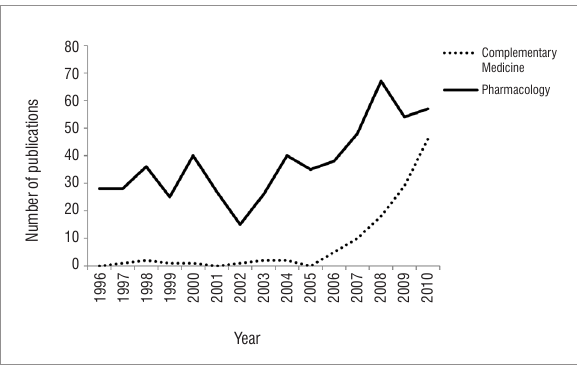
Figure 9: Number of publications from South Africa in Pharmacology and Complementary Medicine during